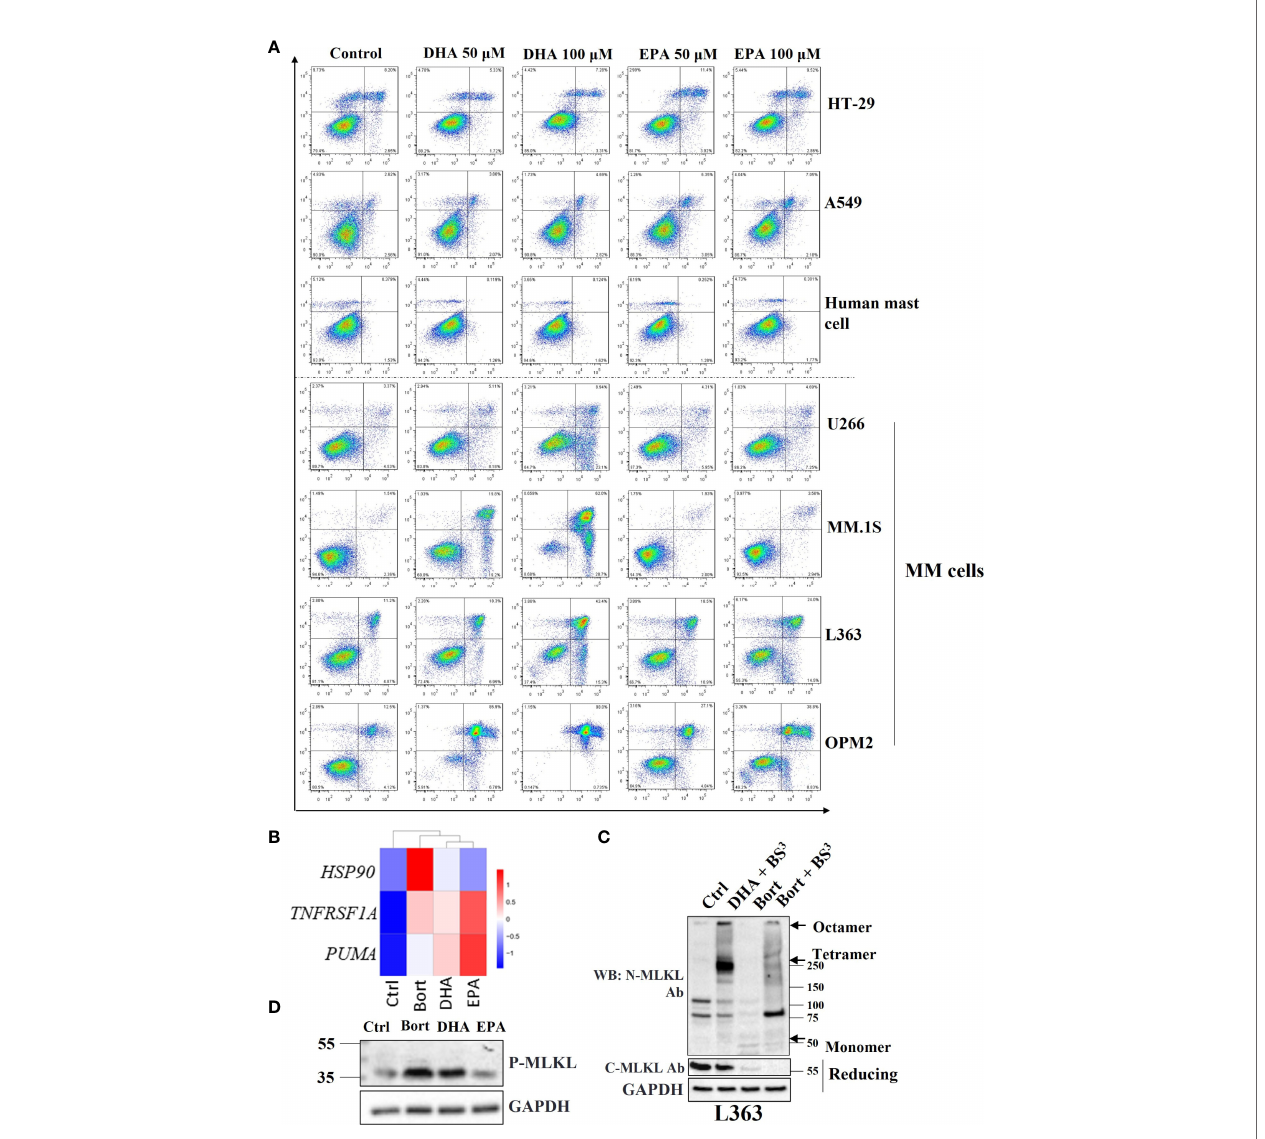
FIGURE 1 | Necroptosis is involved in DHA/EPA and bortezomib-induced cell death in MM cells. (A) Cells were treated with 50 µM and 100 µM of DHA or EPA for 24 h. Cell death was determined by Annexin V and PI staining. (B) OPM2 cells were treated with 50 µM of DHA/EPA or 10 nM of bortezomib. RNA sequencing was performed. The expression levels of HSP90 , TNFRSF1A and PUMA were shown in heatmap. (C) L363 cells were treated with DHA (50 µM) or bortezomib (500 nM) for 24 h and lysed after 1 h incubation with crosslinker BS 3 . Cell lysates were subjected to SDS-PAGE under non-reducing and reducing conditions and immunoblotted with indicated antibodies. Arrows indicate the oligomers of MLKL. (D) Cells were treated with 100 µM of DHA or EPA and 500 nM of bortezomib for 24 h and lysed with RIPA buffer. Whole cell lysates were subjected to western blotting with antibodies against p-MLKL and